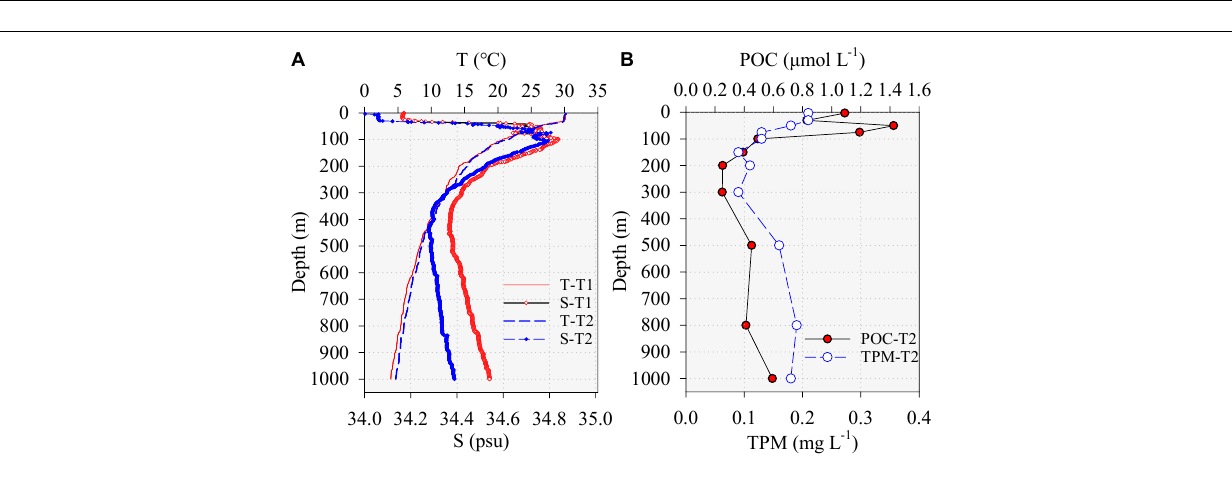
FIGURE 1 | Sampling stations in the northeastern South China Sea and the trajectory of the Lagrangian observation. The intervals between adjacent points denote the trajectory within an hour. The conceptual schematic of the nepheloid layer over the shelf/slope region highlights its ubiquity.